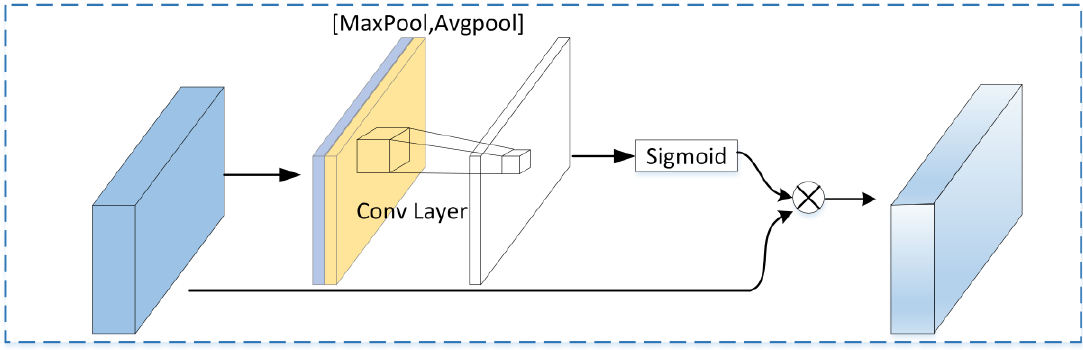
Figure 4. The structure of the spatial attention module (SAM).